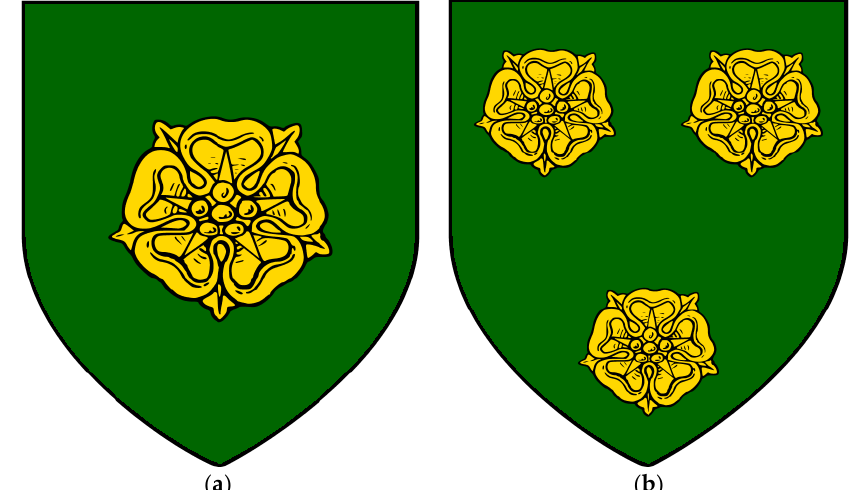
Figure 1. Exceptions to the lack of cadency: ( a ) House Tyrell family arms; ( b ) Personal arms of Ser Loras Tyrell, the third son.